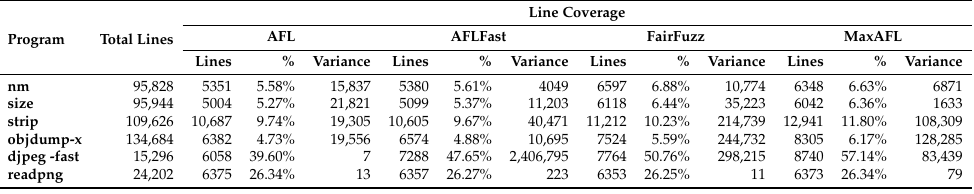
Table 2. Line coverage after 12 h fuzzing. We described the line coverage of each fuzzer in absolute number of lines and percentage of a total lines. We also provide variance of final line coverage in 8 independent